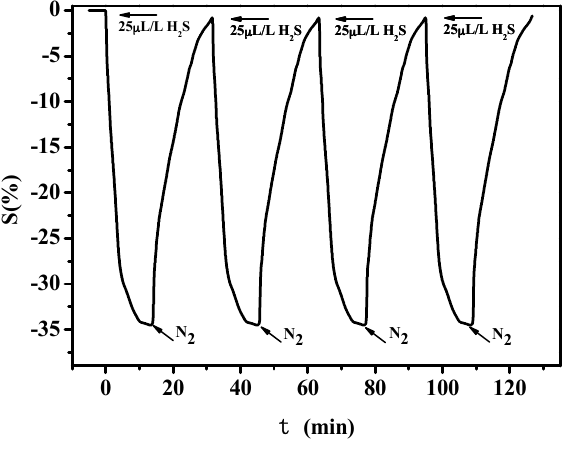
Figure 13. Reversibility curve of PANI-HCl/SSA sensors to H 2 S.